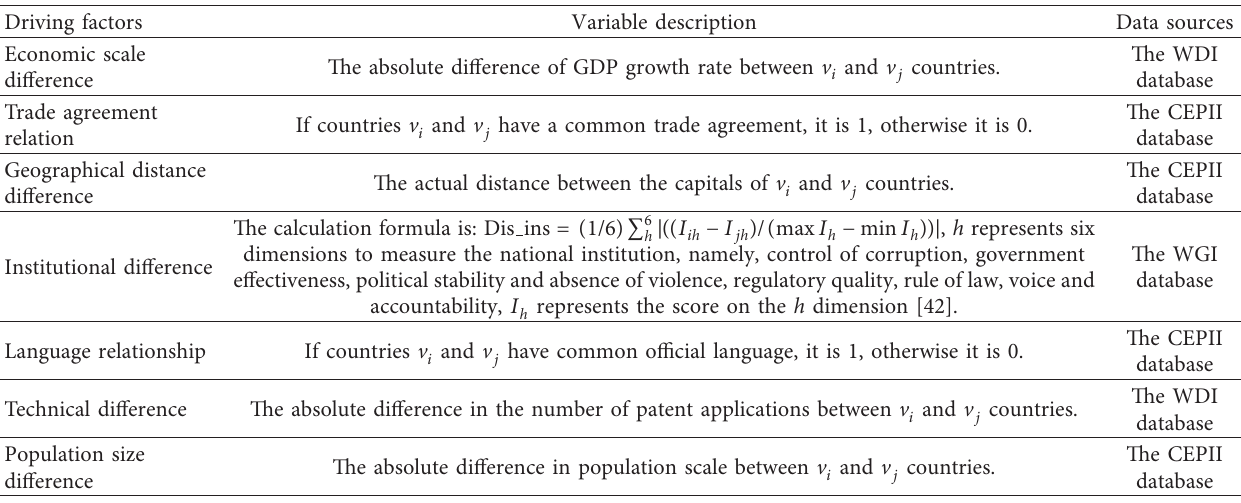
Table 2: Variable description and data